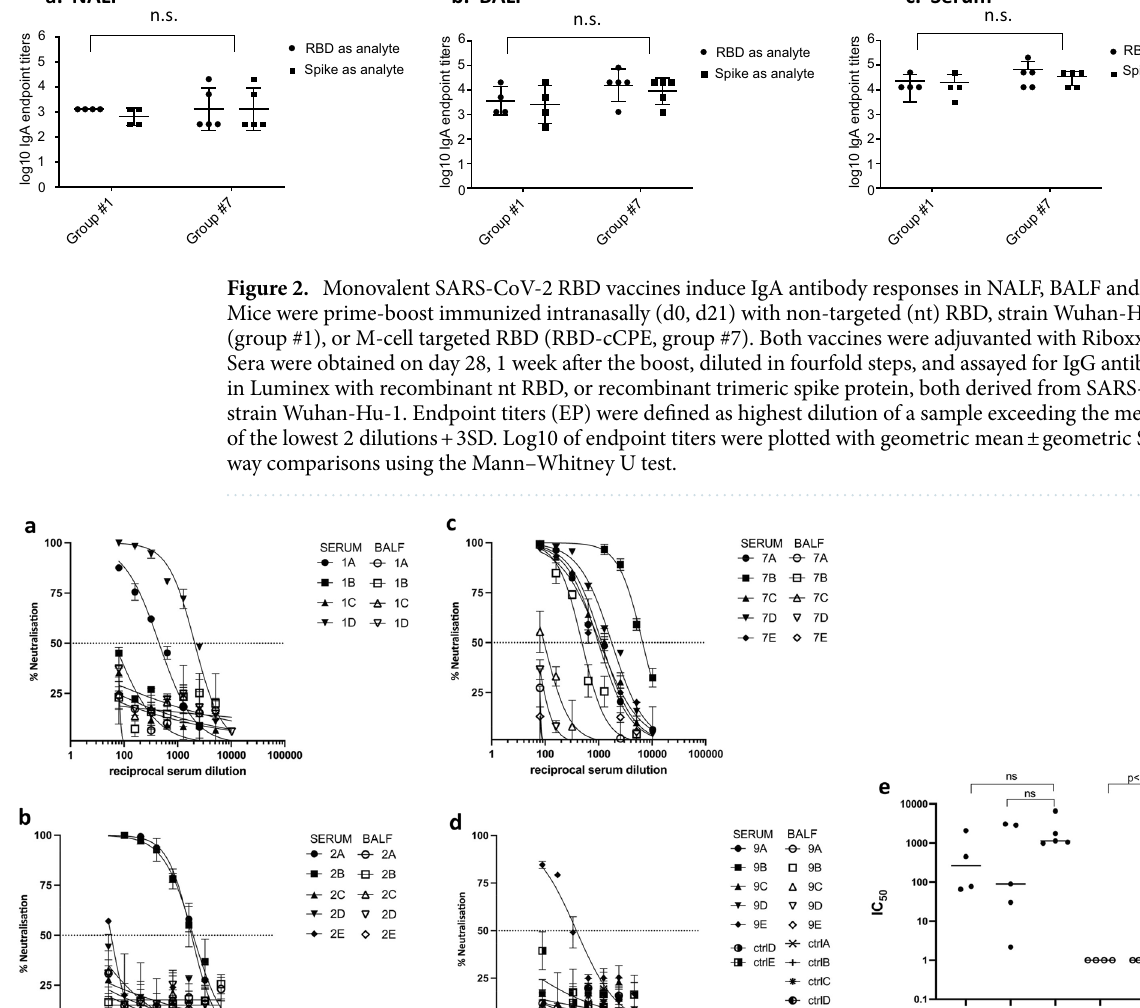
NALF, BALF and serum of mice obtained on day 28 post prime immunization (day 7 post boost) with bivalent SARS-CoV-2/Influenza vaccine were assayed for IgG and IgA antibodies for binding to recombinant RBD (Wuhan-Hu-1/wildtype, or RBD point mutations N501Y, or E484K), or recombinant trimeric spike protein (WT, variants B.1.1.7/alpha and B.1.351/beta), or recombinant H1-HA 1 (consensus sequence based on H1N1/swine/Guangxi/3843/2011), using Luminex technology for IgG and ELISA for IgA, respectively. High IgG antibody titers with similar binding to SARS-CoV-2 RBDs (WT, point mutants), WT and mutated spike-trimers were detectable in NALF, BALF and serum, with EP titers in the 1E4 to 5E5 range (Fig. 5a–c). IgG antibodies against recombinant monomeric H1-HA 1 were detected in all three body fluids, with highest titers in NALF and BALF (Fig. 5a–c). Similarly, IgA antibody reactive with RBD and spike was detected in NALF, BALF and serum, with EP ranging from 1E4 to